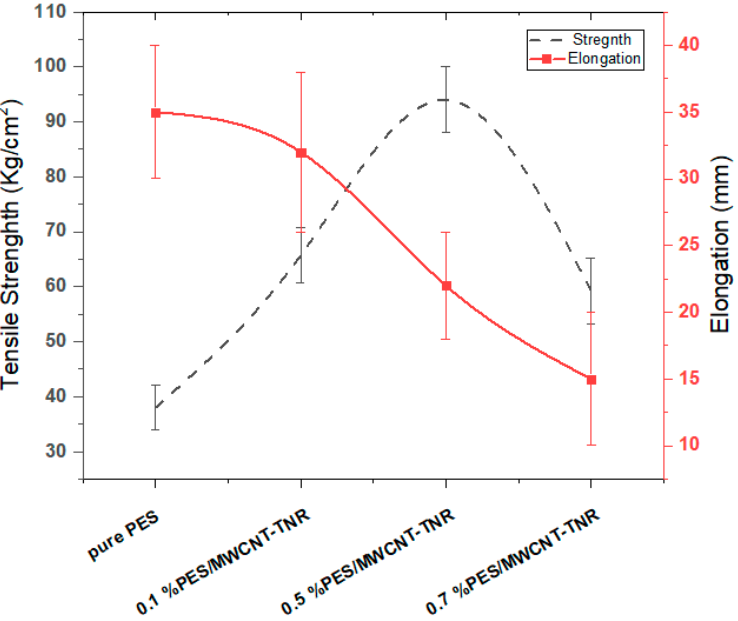
Figure 6. Tensile strength and elongation of the pure and blend membranes.